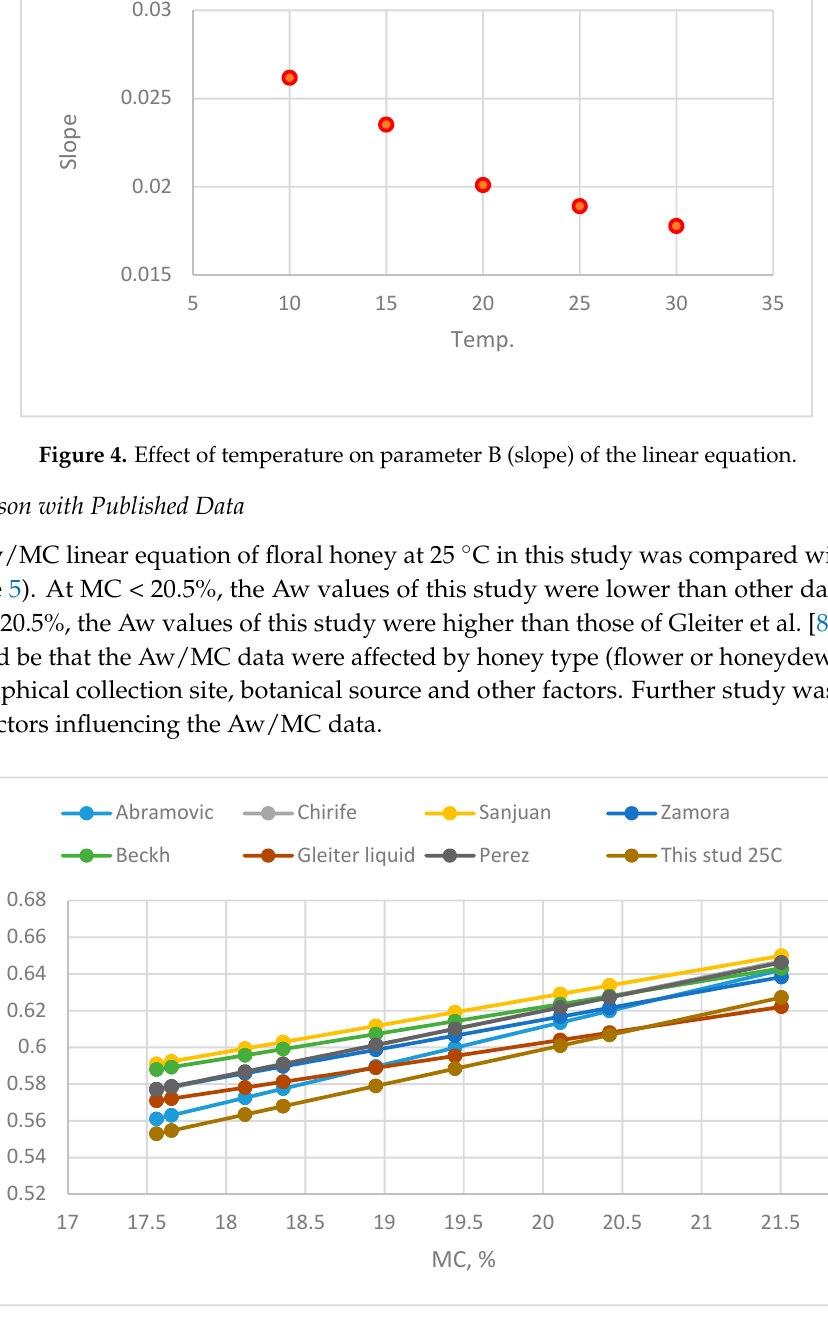
Figure 4. Effect of temperature on parameter B (slope) of the linear equation.